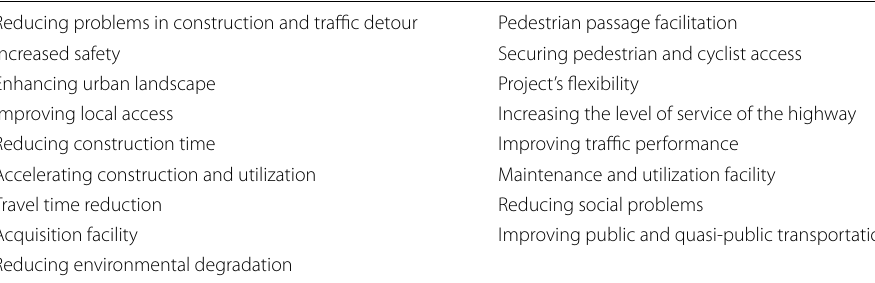
Table 4 Qualitative parameters analyzed in each project Reducing problems in construction and traffic